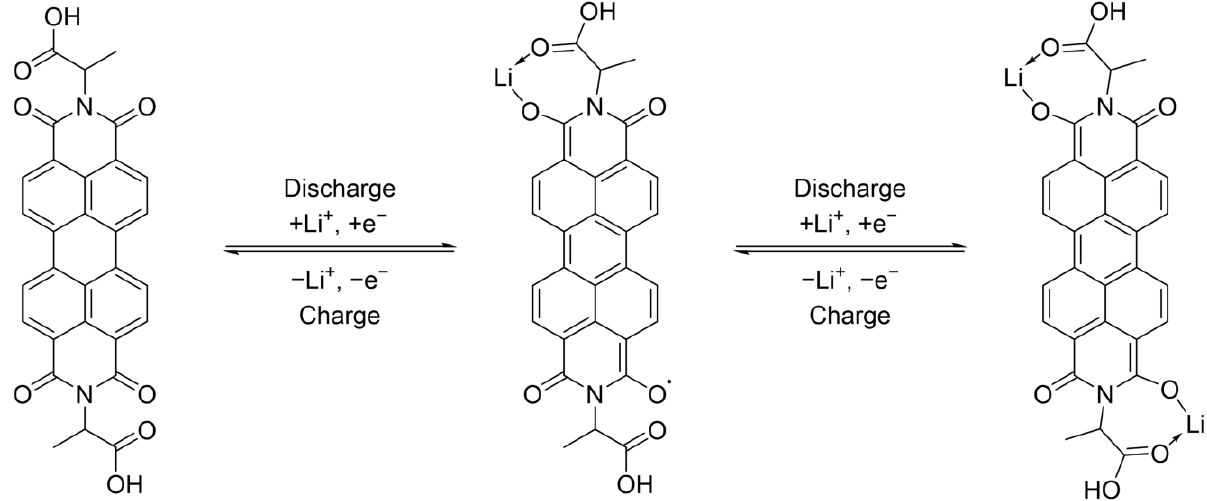
Figure 4. ( a ) ATR FT-IR spectra of PDI_A cathode at different charged states on the specific point of first galvanostatic charge–discharge profile; ( b ) optimized structure of PDI_A, LiPDI_A, and Li 2 PDI_A based on DFT calculations.